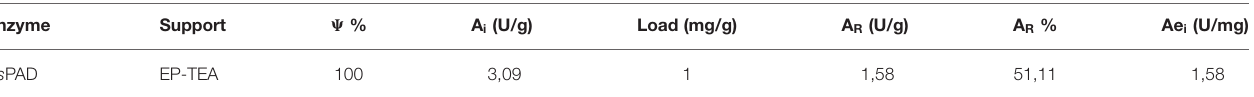
TABLE 2 | Heterogeneous biocatalyst characterization.